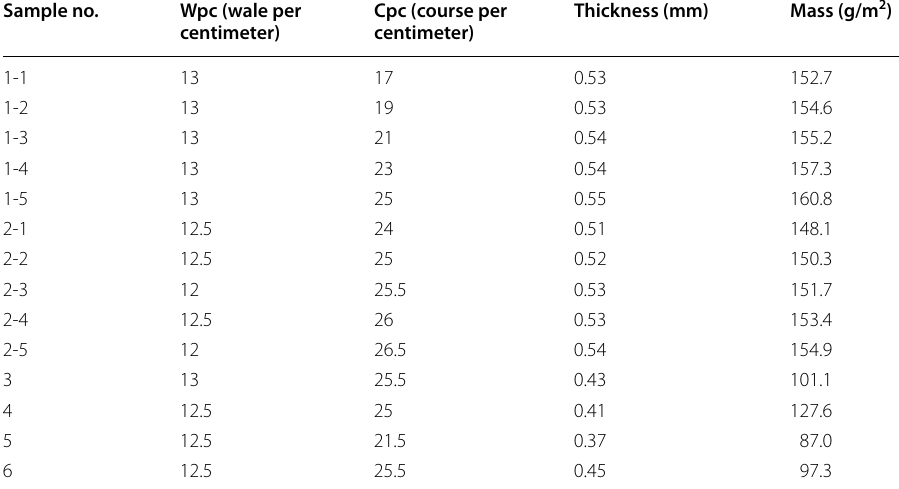
Table 2 The specification of samples Sample